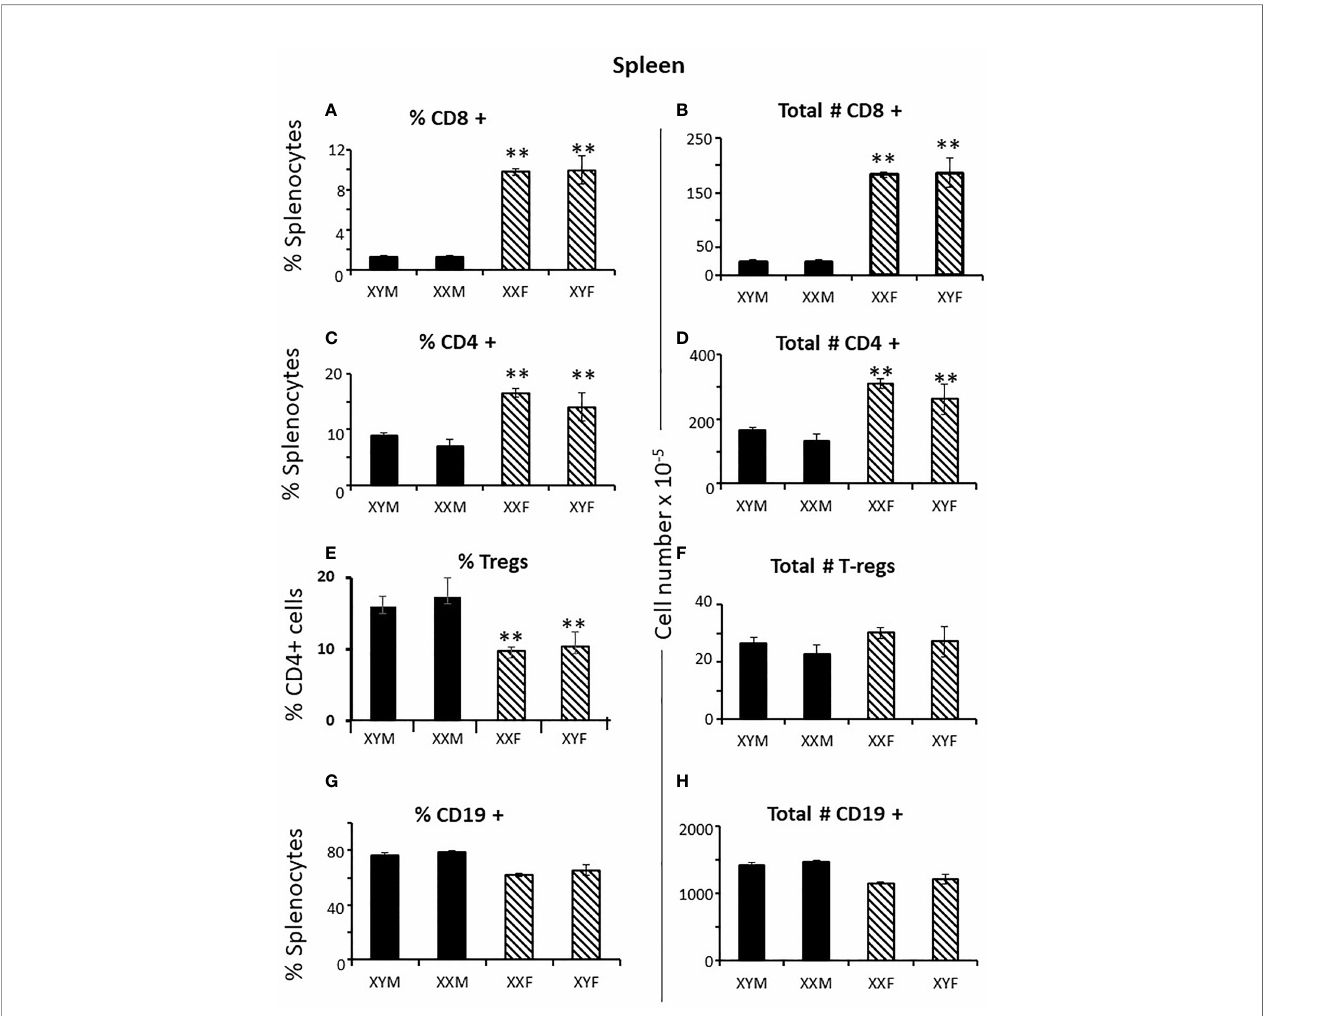
FIGURE 1 | Cellular content (percentages and numbers) of adult FCG spleens 4 weeks after gonadectomy. Data are presented as a percentage of gated lymphocytes present in the spleen except for Tregs (CD4+CD25+Foxp3+), which are presented as a percentage of CD4 single positive cells. Data are the mean ± SD and are derived from 3-5 animals per genotype. **, different from both male genotypes,